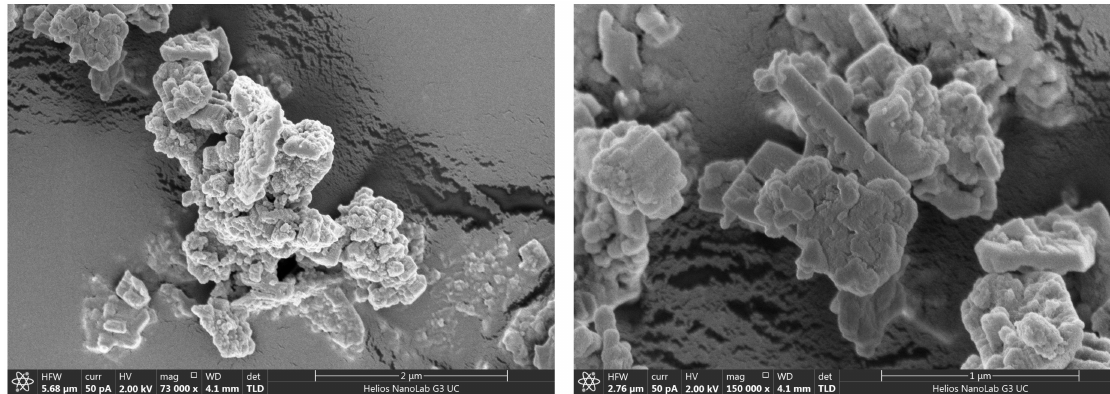
Figure 15. SEM images of boron